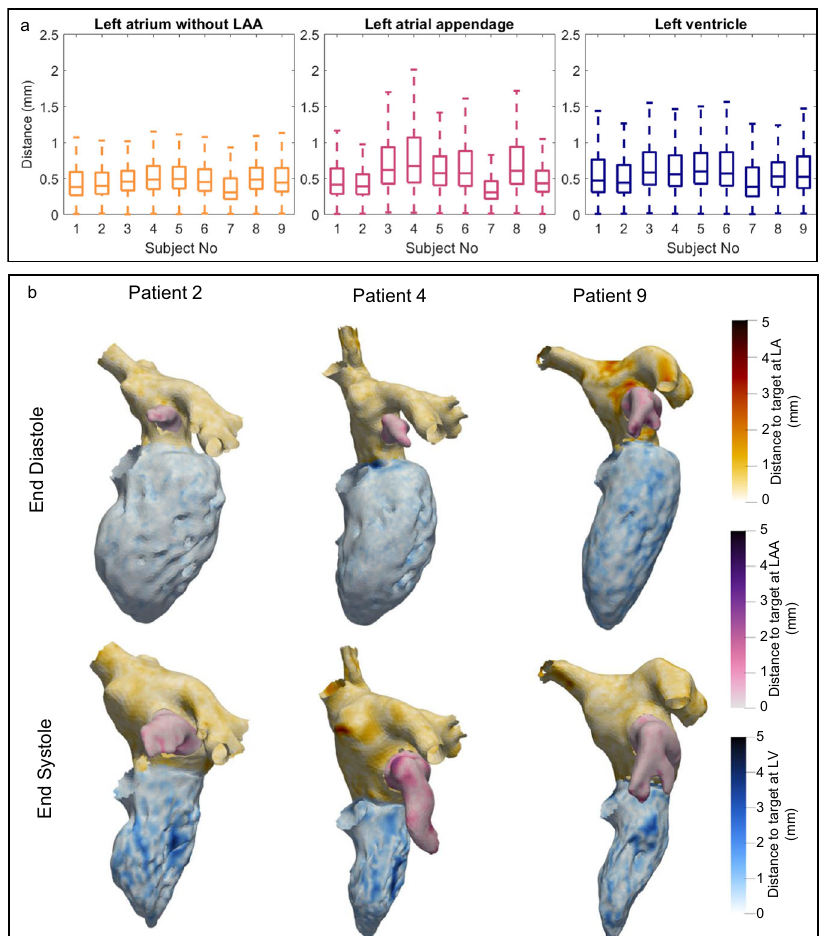
Fig. 2 Evaluation of distance between registration and target surface. a Boxplot diagrams of distance between registration and target surface. The central mark indicates the median, bottom and top edges of the box indicate the 25th and 75th percentiles, respectively. The whiskers extend to the most extreme data points not considered outliers, and the outliers are not shown for better visibility. b Visualizations of the distance from registration to target in 3